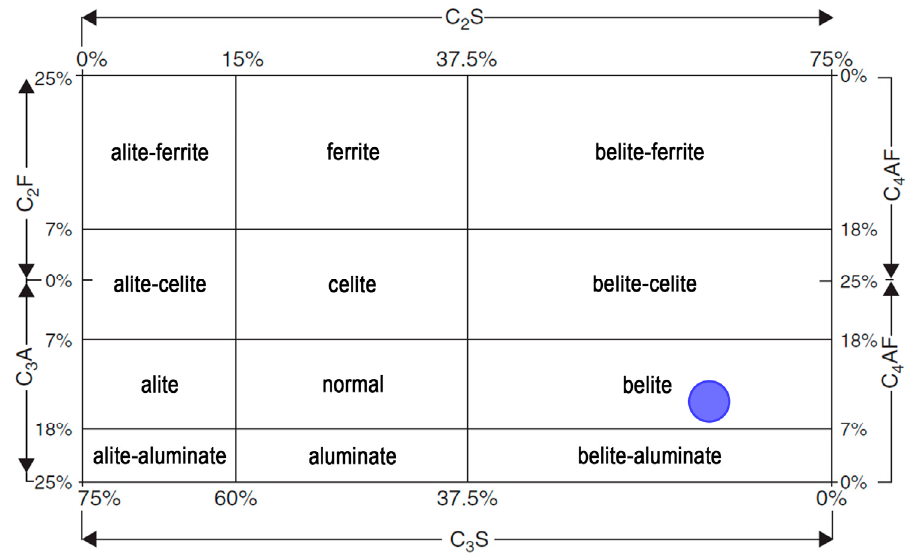
Figure 7. Classification of cement types according to the composition of their majority phases. Blue area: target cement type. (Adapted from reference [77]).